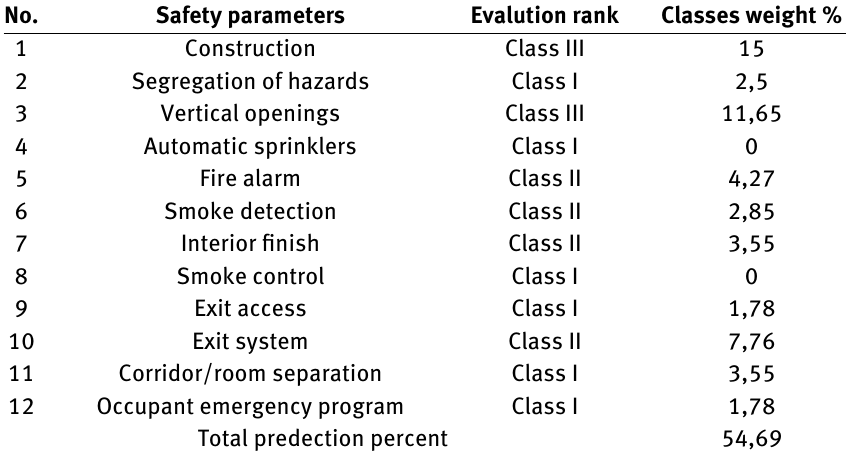
Table 4: Predictive score assessment